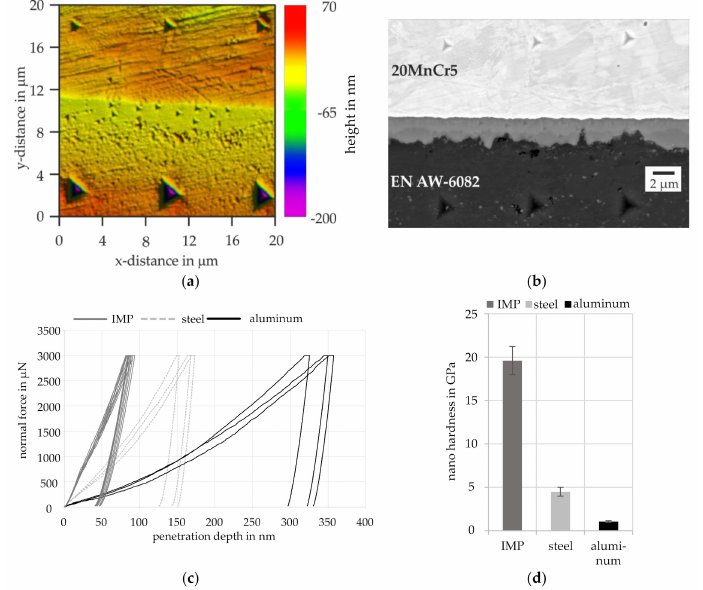
Figure 9. Examination of a joining zone formed at 575 ◦ C, 120 s and 5890 N with nanoindentation measurements with a test force of 3000 µ N: ( a ) scanning probe microscopy (SPM) image, ( b ) SEM image, ( c ) force-penetration curves, ( d ) nano hardness of aluminum, steel and the intermetallic phase